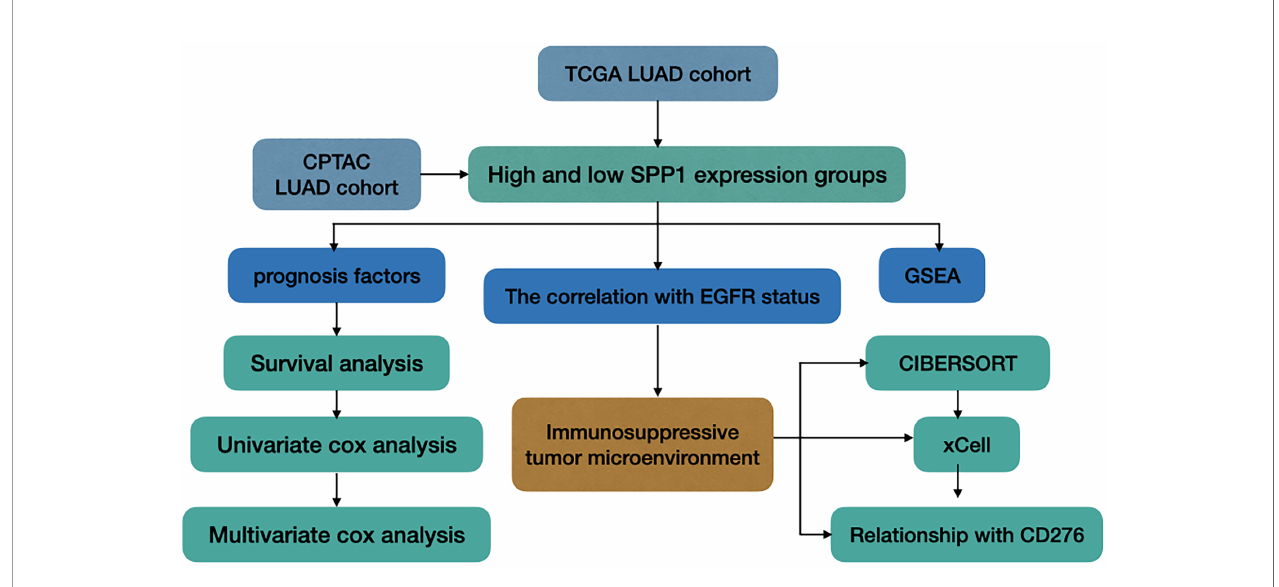
FIGURE 1 | Study work fl